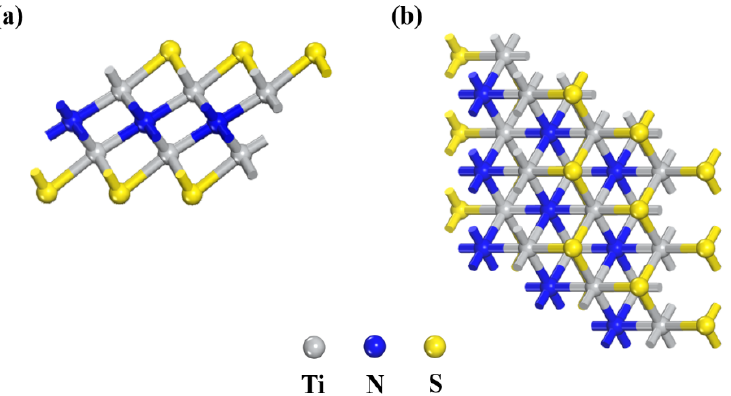
Figure 3. ( a ) Side and ( b ) top views of Ti 2 NS 2 . Yellow balls represent S atoms. Gray balls represent Ti atoms. Blue balls represent N atoms.